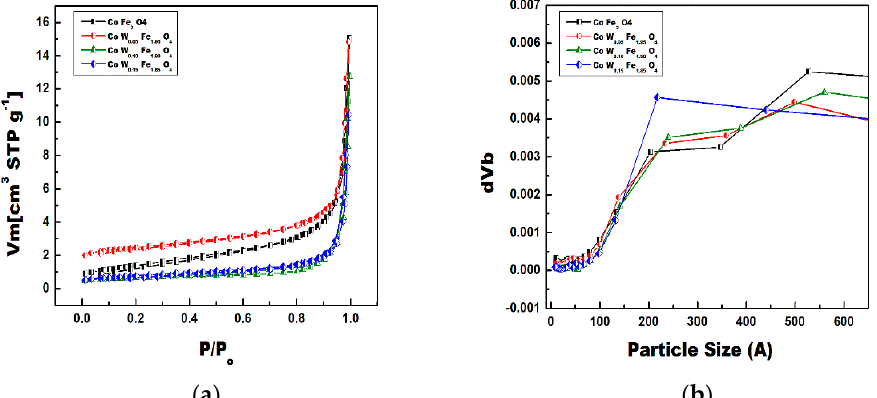
Figure 8. ( a ) BET plots, and ( b ) Pore-size distribution behavior of CoFe 2 O 4 (red colure), 0.5% W- CoFe 2 O 4 (blue colure), 0.1% W-CoFe 2 O 4 (olive colure), and 0.15% W-CoFe 2 O 4 (wine colure) of W-substituted CoFe 2 O 4 nanoparticles. Table 3. Surface properties of CoFe 2 O 4 with powder with different